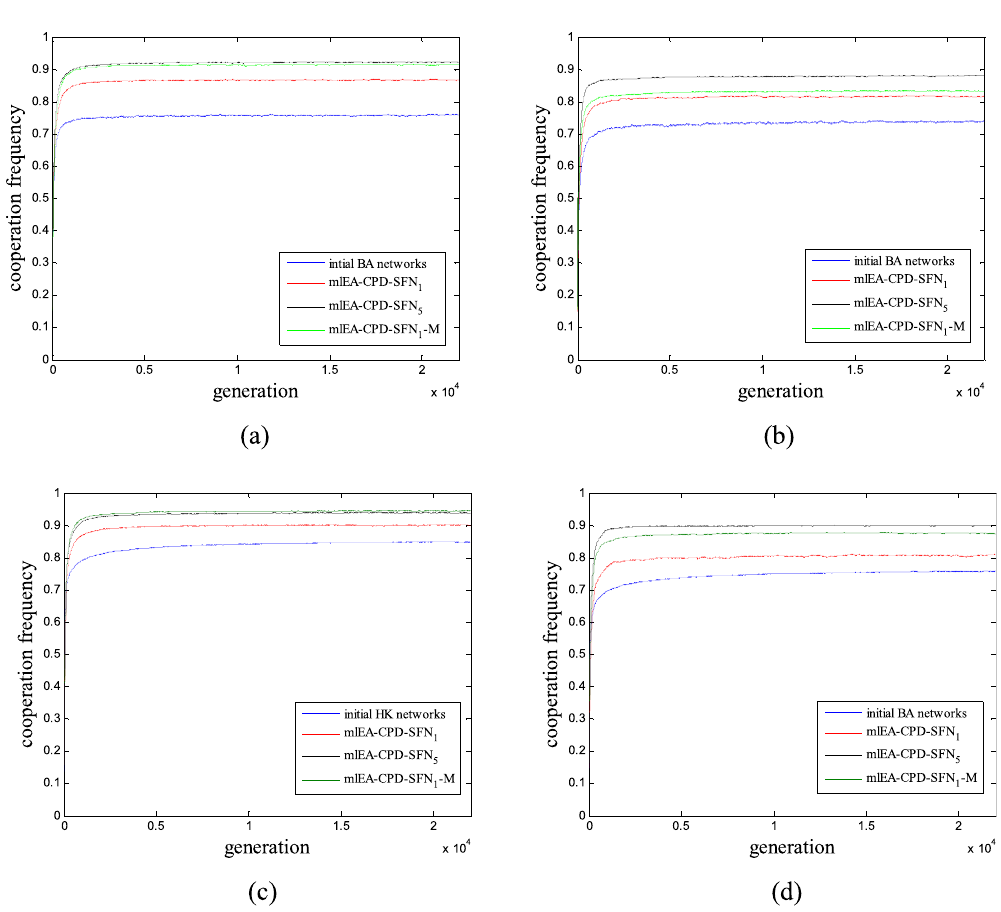
Figure 5. Mean cooperation frequency of structures during the game process. ( a ) 1000-node BANs. ( b ) 500- node BANs. ( c ) 1000-node HKNs. ( d ) 500-node HKNs. Apparently, prolonging simulation time has little influence upon the evaluation results, as cooperation frequency has already converged around 1.1 N generation (Mode-A). Moreover, mlEA-C PD -SFN 5 performs best in optimizing population structure and mlEA-C PD -